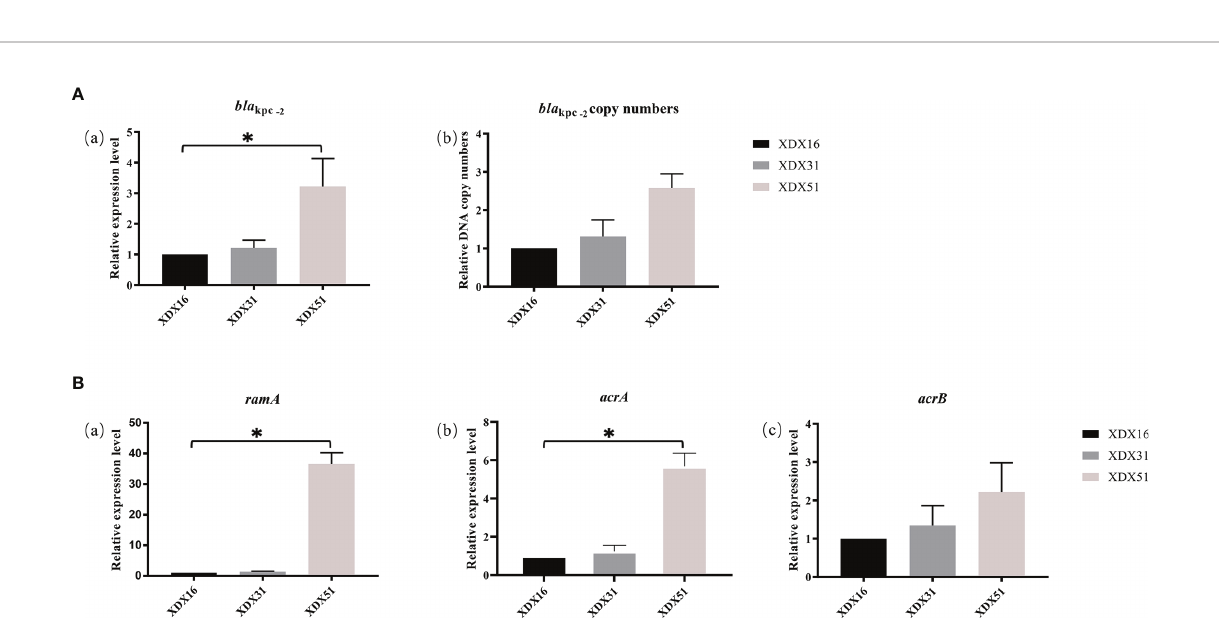
FIGURE 3 | Schematic diagram of the gene structure. (A) The ramR gene was interrupted by IS Kpn14 in XDX51; the IRL of IS Kpn14 was 5 ’ -GGTAATG-3 ’ , and the IRR was 5 ’ -CATTACC-3 ’ . (B) The wbbL gene was interrupted by IS Kpn26 in XDX51, the IRL of IS Kpn26 was 5 ’ -GGAAGGTGCGAA-3 ’ , and the IRR was 5 ’ - TTCGCACCTTCC-3 ’ .